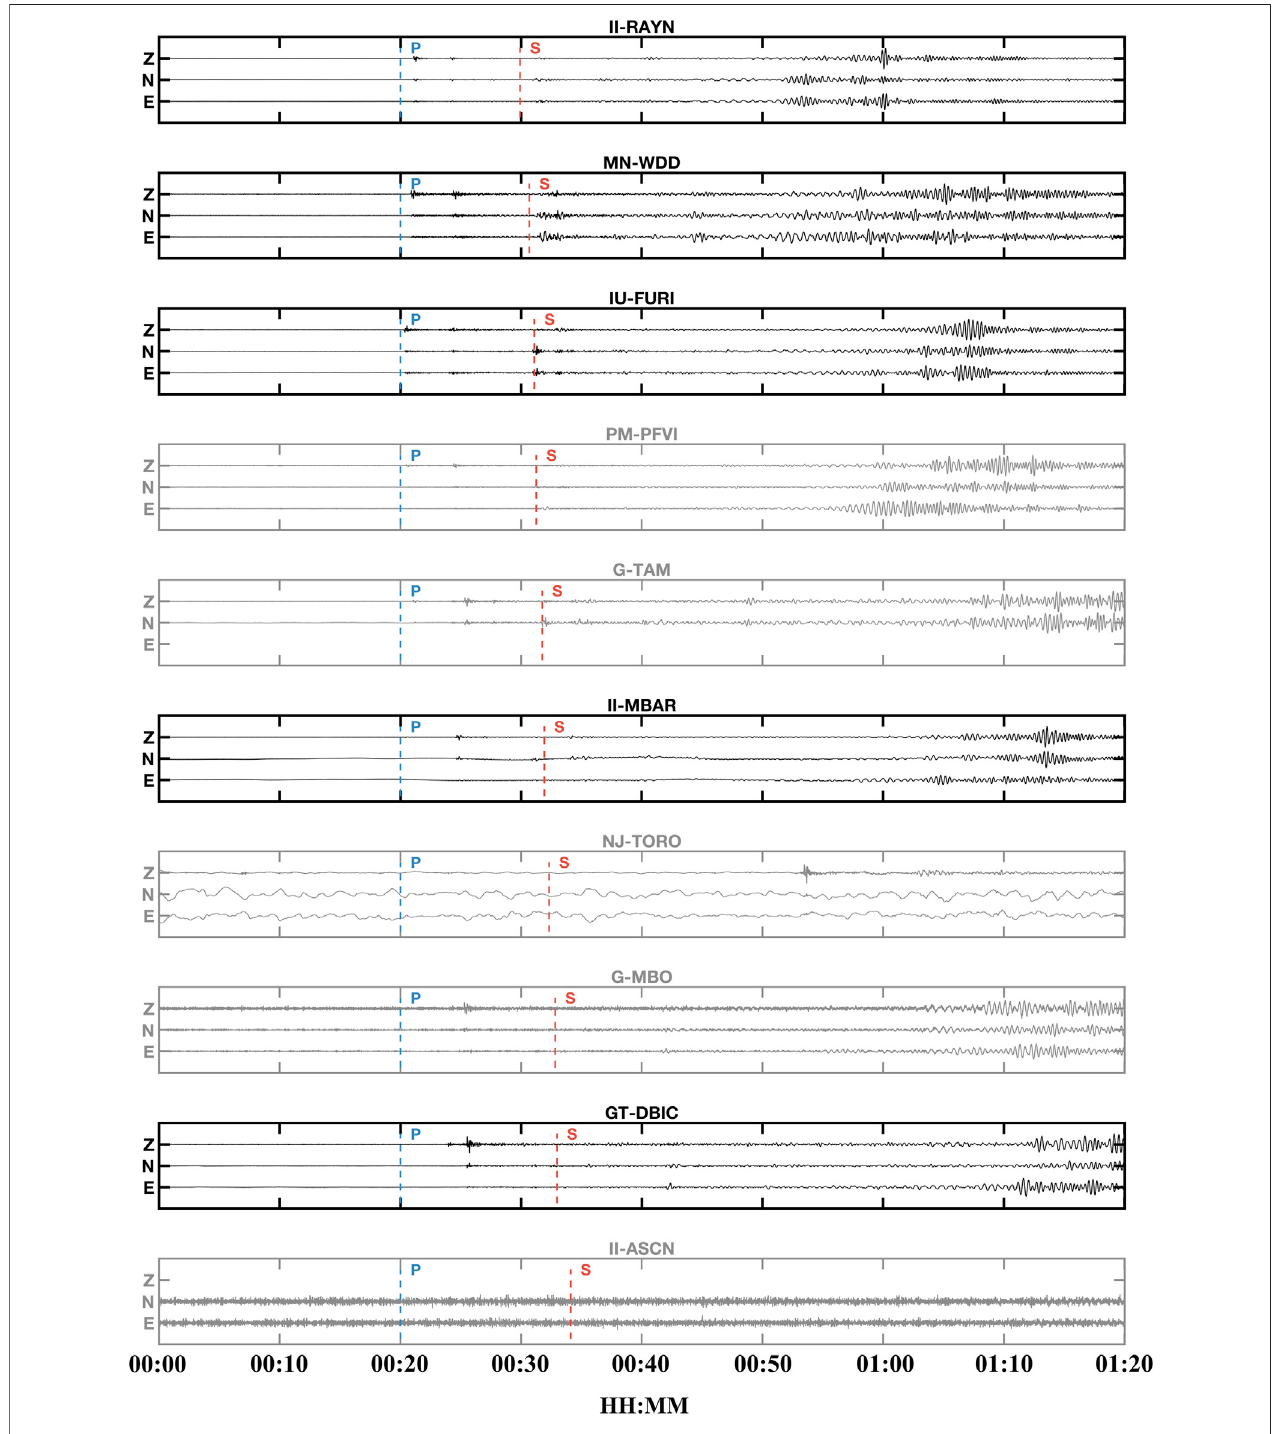
FIGURE 2 | Seismograms at stations in or close to Nigeria using an 80 min time window. Traces are amplitude normalized. Stations used for further analysis, markedinblack,arethosethatpassthedataselectioncriteria(greentrianglesin Figure1B ).Ineachtrace,the fi rstP(blue)andS(red)arrivalsoftheM6.6Hokkaidoevent are shown with the station code to the top.